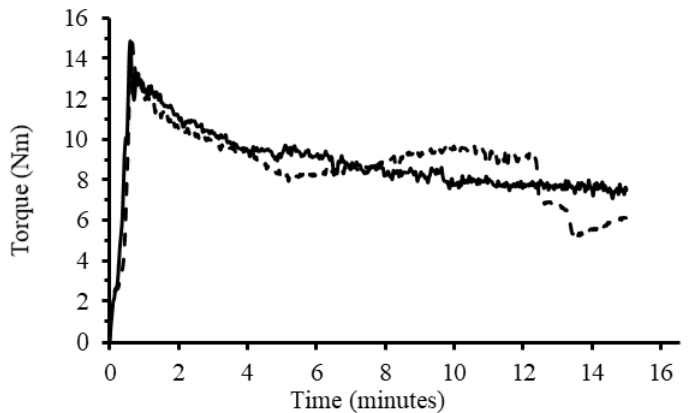
Figure 4. Typical torque variation at 90 °C and 40 rpm for starch with water ( ) and starch with water and OSA ( ).